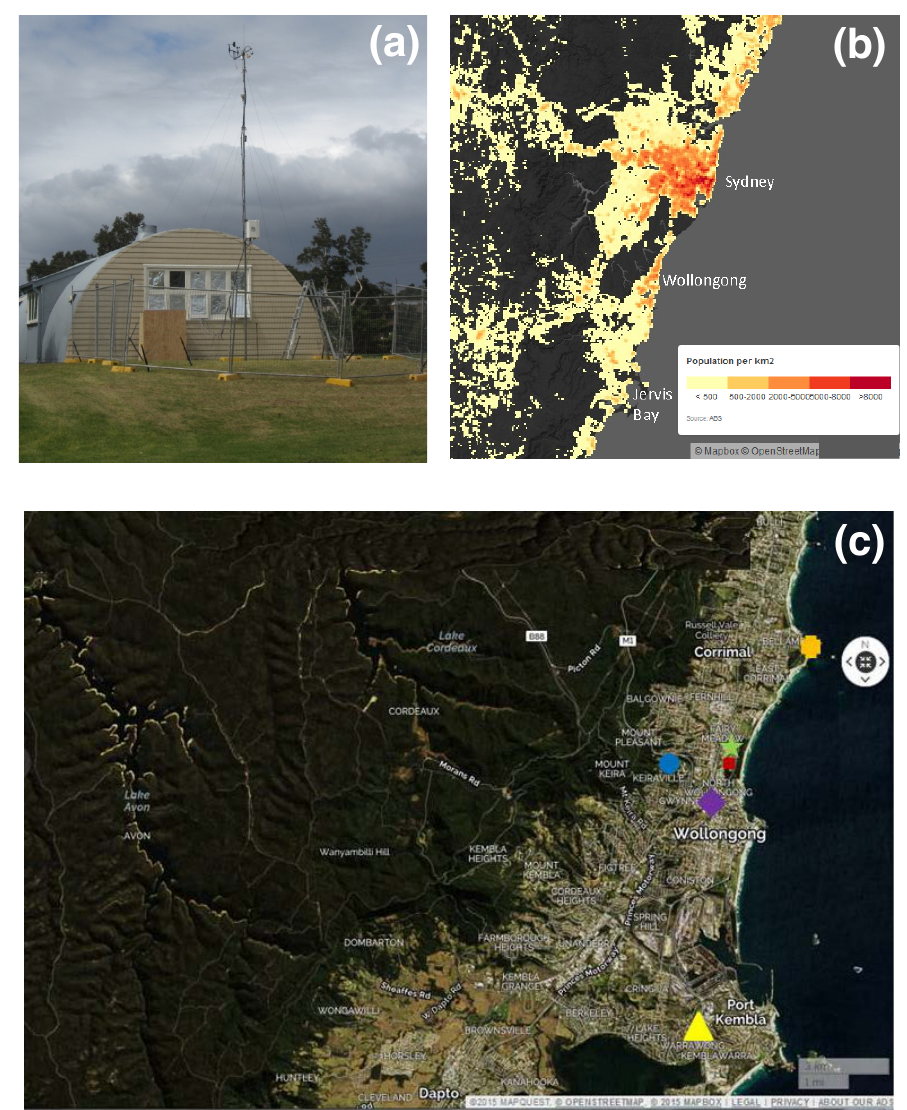
Figure 1. (a) The hut that housed most of the instruments during MUMBA and the sample mast. (b) A population density map for the region based on the Australian Bureau of Statistics data from August 2011 (http://www.abs.gov.au/AUSSTATS/abs@.nsf/Lookup/1270.0.55. 007Main+Features12011?OpenDocument) (c) A satellite view of the region showing the main MUMBA site (green star), the Wollongong Science Centre (red square), the Wollongong EPA air quality station (purple diamond), the University of Wollongong (blue circle), the Bellambi automatic weather station (orange hexagon) and the ANSTO radon detector site at Warrawong (yellow triangle). Also visible is the large industrial area at Port Kembla and the extensive forested regions to the west. The image was created using www.mapquest. com, OpenStreetMap